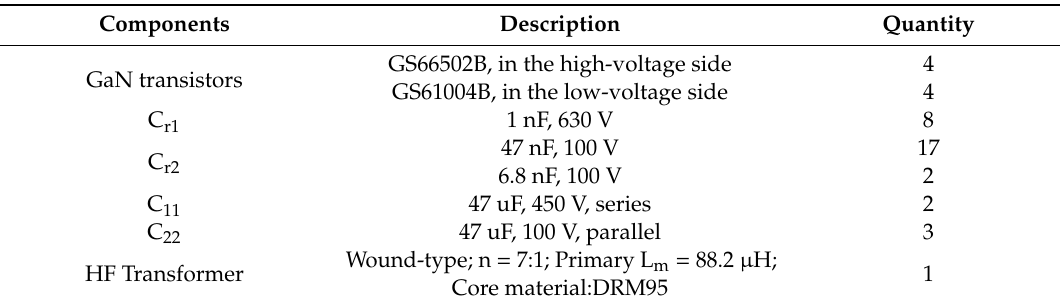
Figure 10. Main experimental waveforms of the forward mode. ( a ) Waveform of i Lr when f s = 312 kHz; ( b ) waveform of i Lr when f s = 435 kHz; ( c ) waveform of i Tr2 when f s = 312 kHz; ( d ) waveform of i Tr2 when f s = 435 kHz.